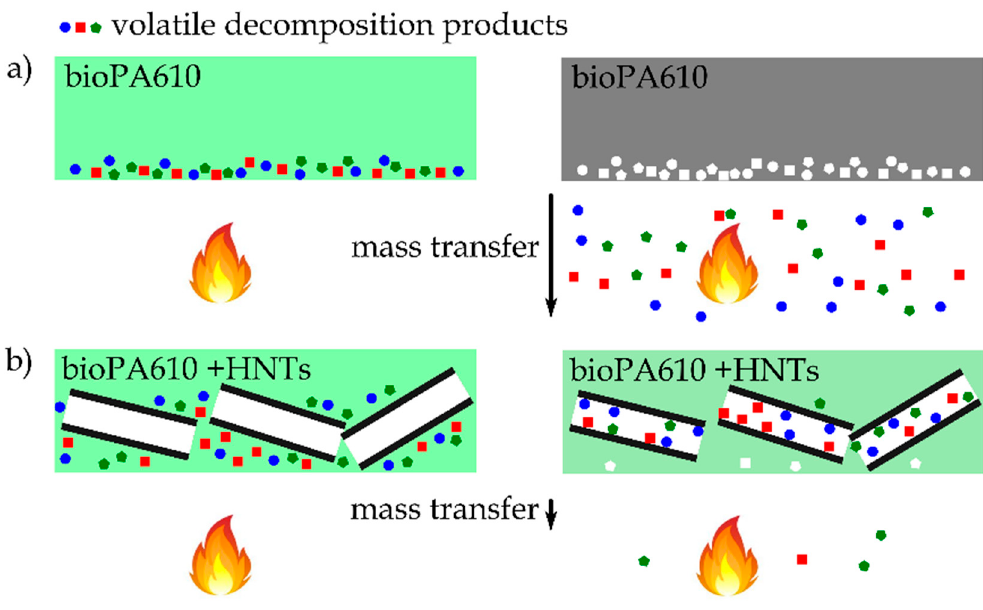
Figure 11. Scheme of the fire retardancy enhancement by HNTs by the entrapment of volatile decomposition products and delaying the mass transfer in ( a ) bioPA610 and ( b ) bioPA610 + HNTs.